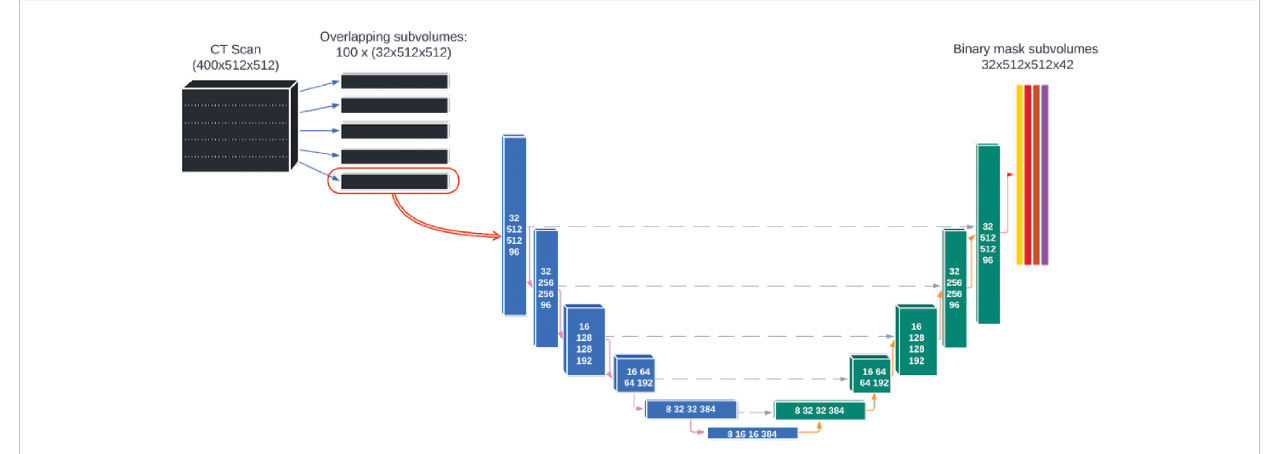
FIGURE 2 The architecture of the deep learning model used for autosegmentation of organ-at-risk for head and neck cancer radiation therapy.